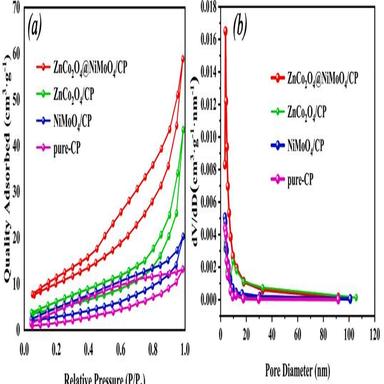
(a) Nitrogen adsorption–desorption type IV isothermal hysteresis curves; (b) pore size distribution curves.